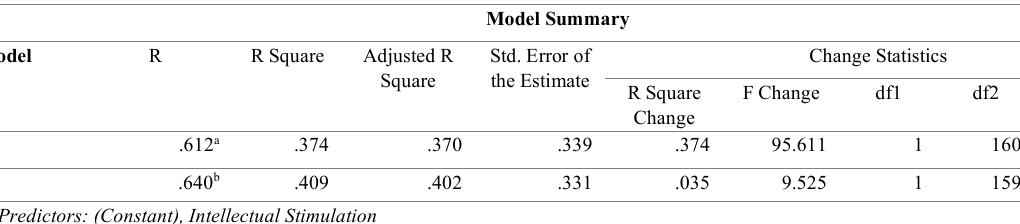
Table 5 : Multiple Linear Regression Analysis of Employee Motivation as a